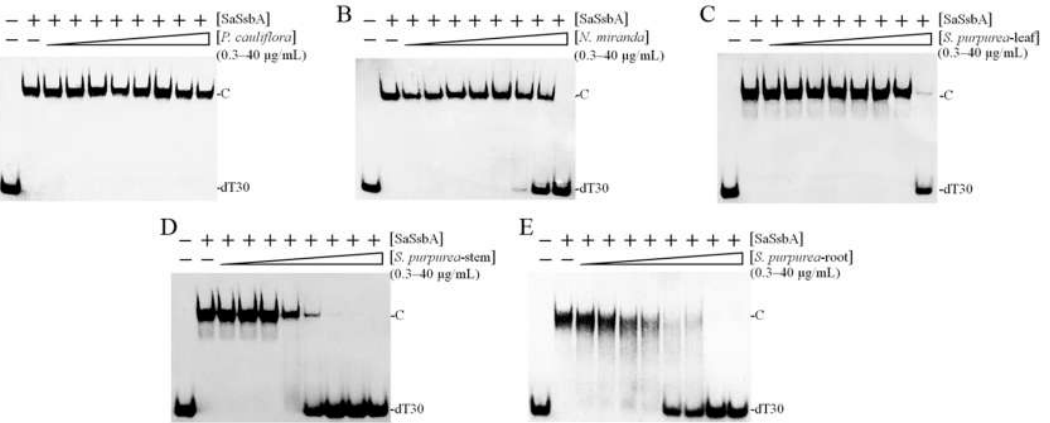
Figure 6. Inhibition of the ssDNA binding activity of SaSsbA by plant extracts. SaSsbA (0.625 μM) was incubated with extracts of ( A ) P. cauliflora , ( B ) the stem of N. miranda , ( C ) the leaf of S. purpurea , ( D ) the stem of S. purpurea , and ( E ) the root of S. purpurea . These extracts were obtained using 100% acetone. Among these extracts, the stem extract of S. purpurea exhibited the greatest inhibitory effect against